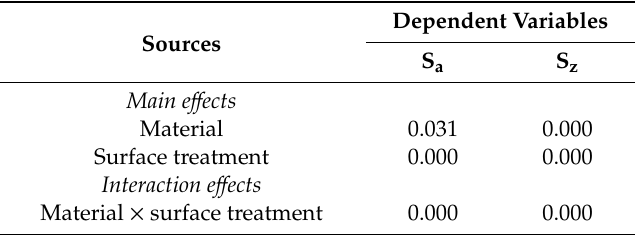
Table 3. Full factorial analysis of variance results (exact significance